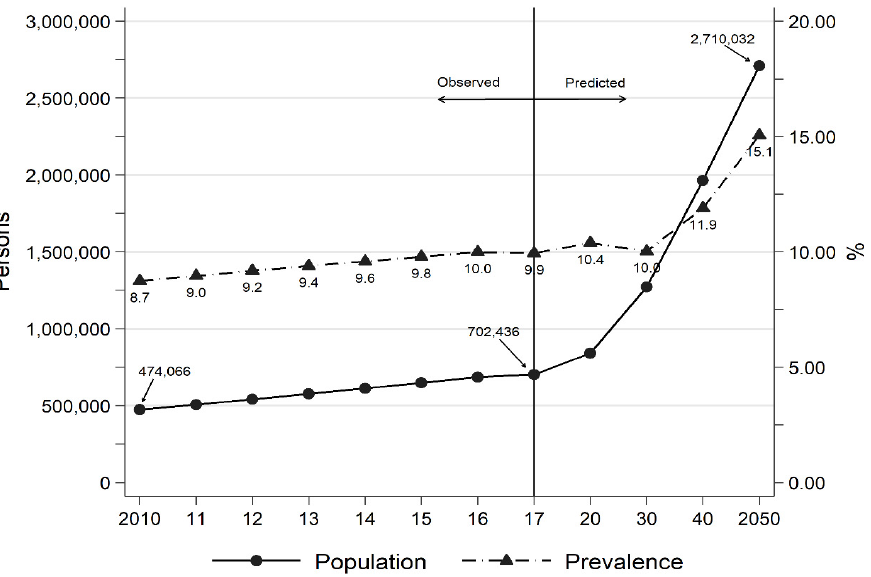
Figure 1. Trends in the Number of Persons with Alzheimer’s Disease and Prevalence Rate in Korea, Korea, 2010–2050.